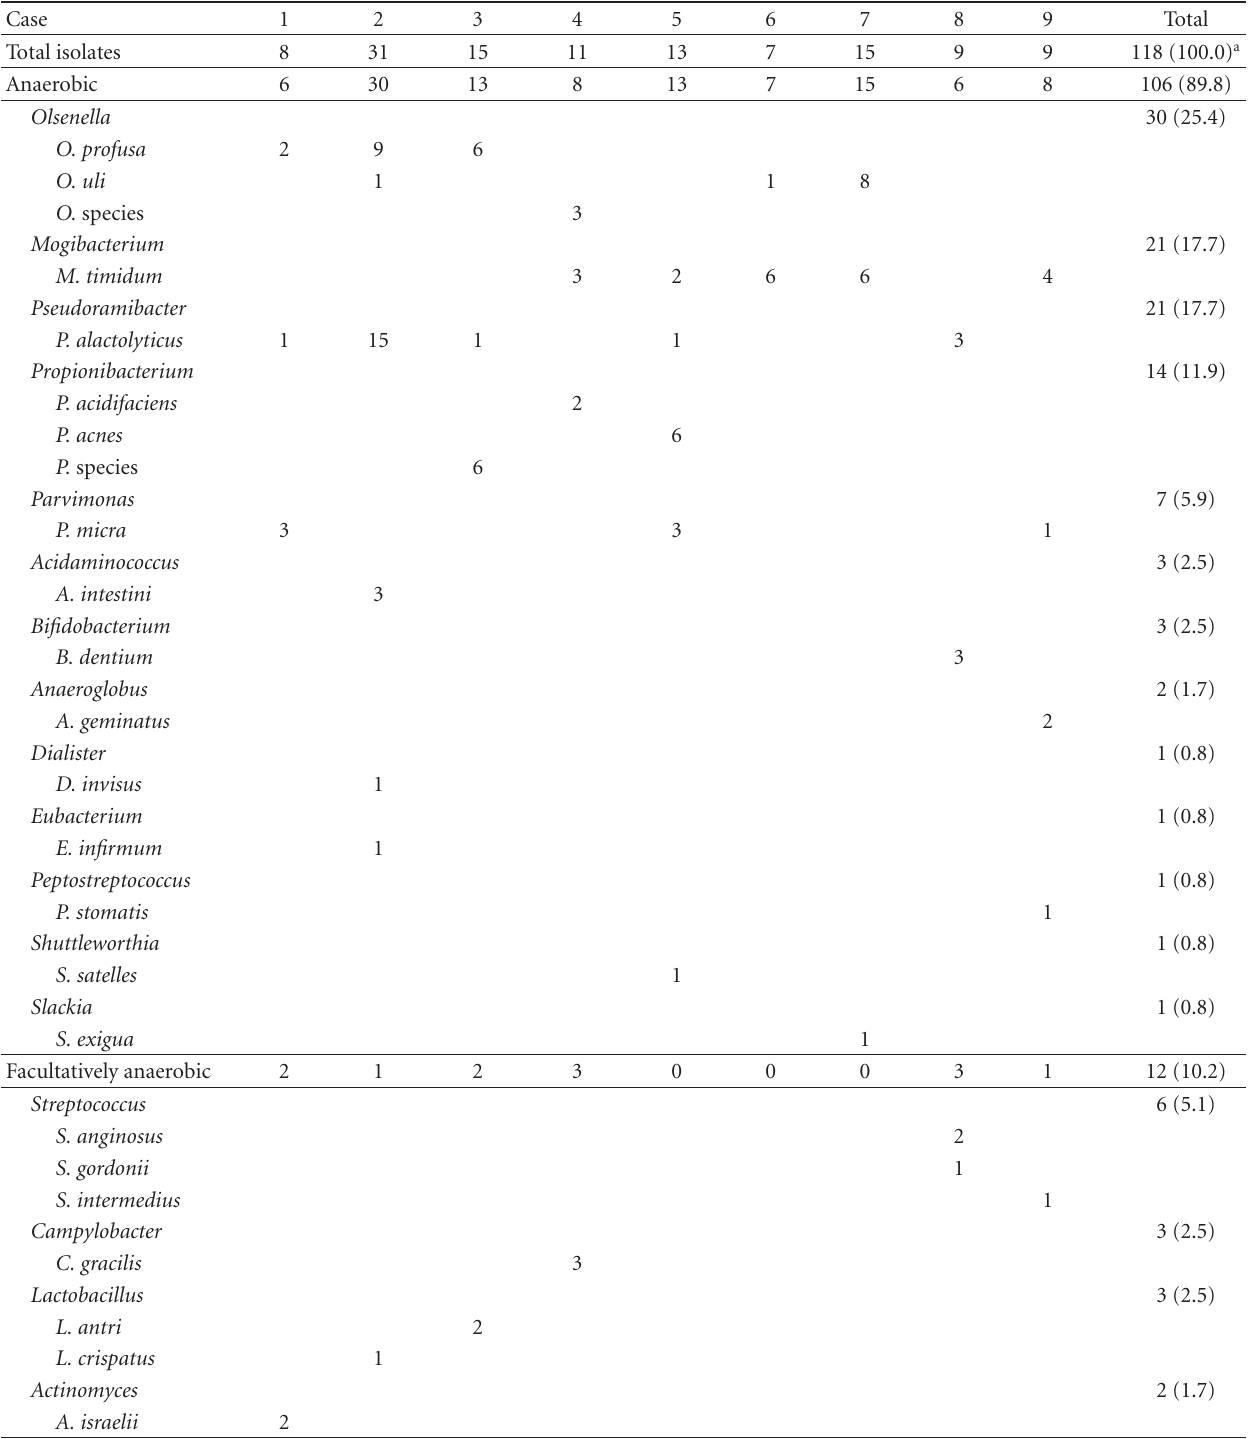
Table 2: Number of bacterial isolates obtained from infected root